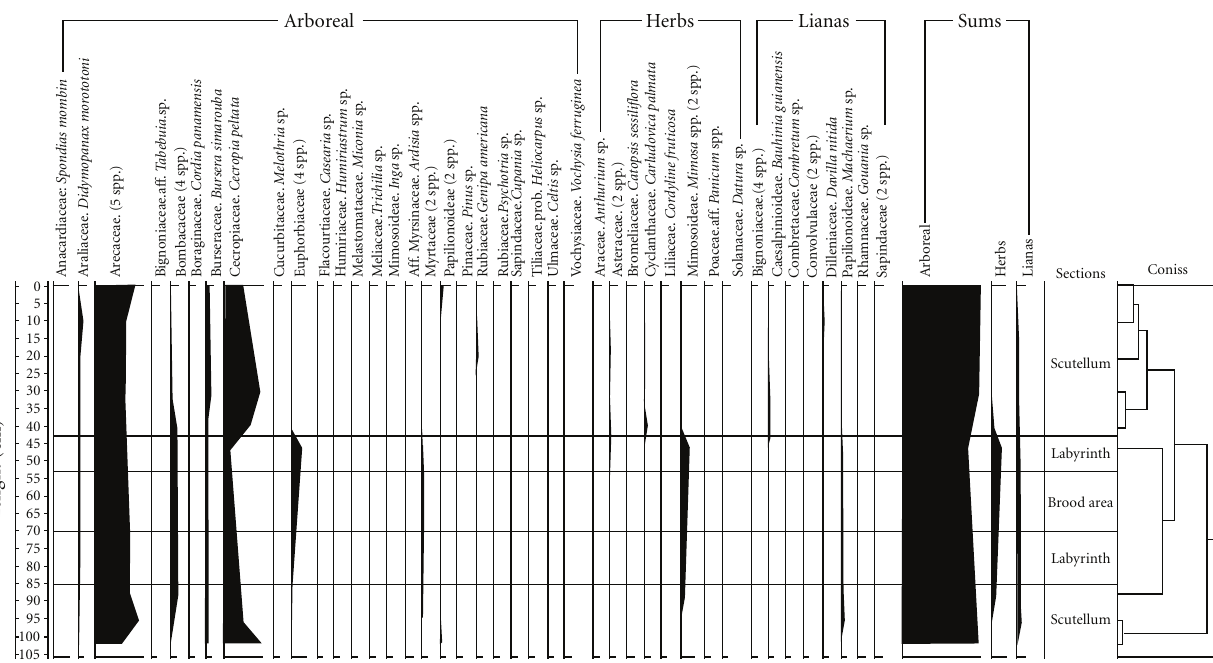
Figure 4: Scutellum pollen stratigraph of the 20-year-old nest of Trigona corvina .